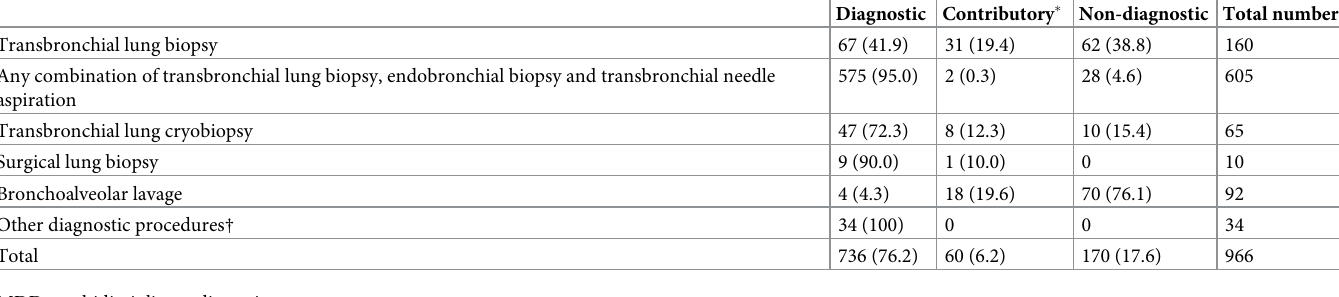
Table 2. Details of invasive procedures performed during evaluation for obtaining the histological diagnoses of ILDs in study subjects (n = 966). Transbronchial lung